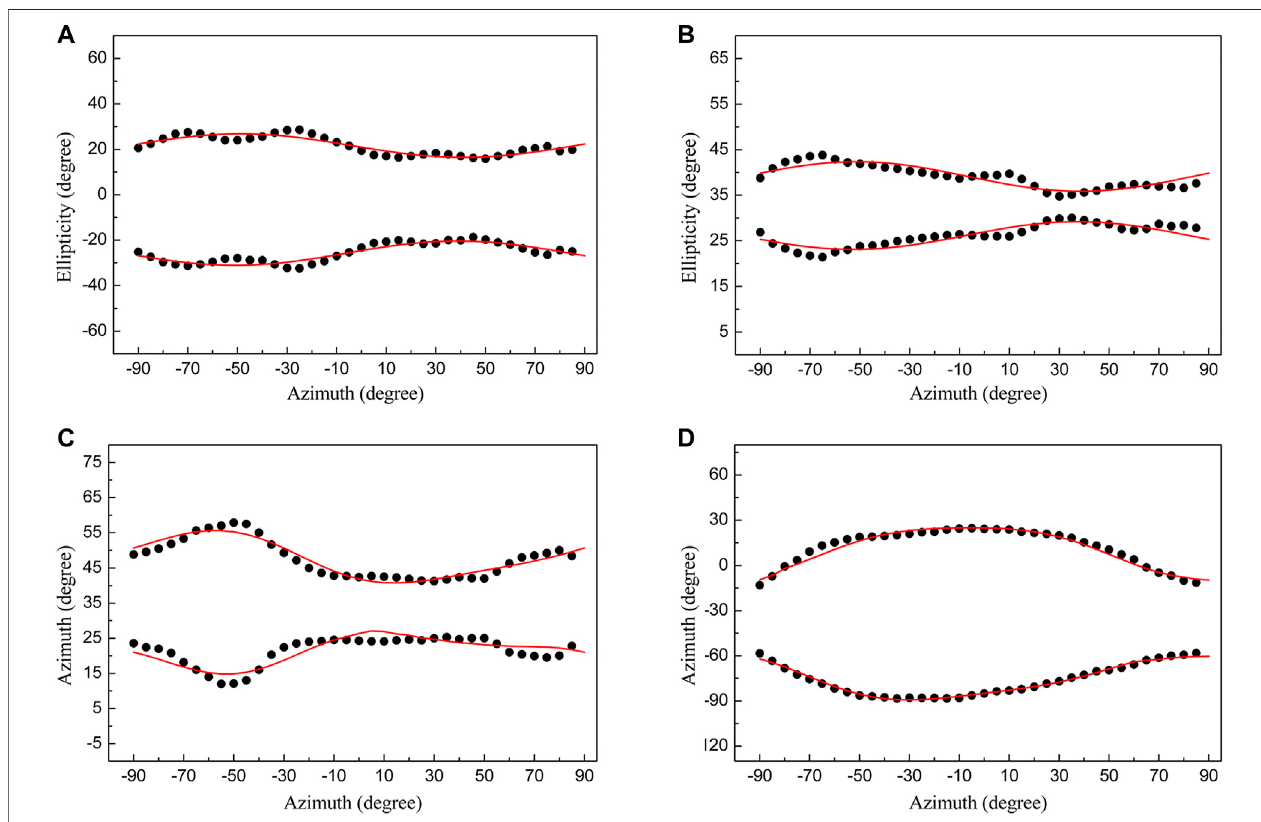
FIGURE 7 | Simulated curves and experimental data of orbital polarization holographic manipulation in terms of OPHGs ( l R1 = 1 and l R2 = 1). Figures 7A – D and Figures 4A – D are in one-to-one correspondence. There is an agreement between the theoretical analysis and experimental results.